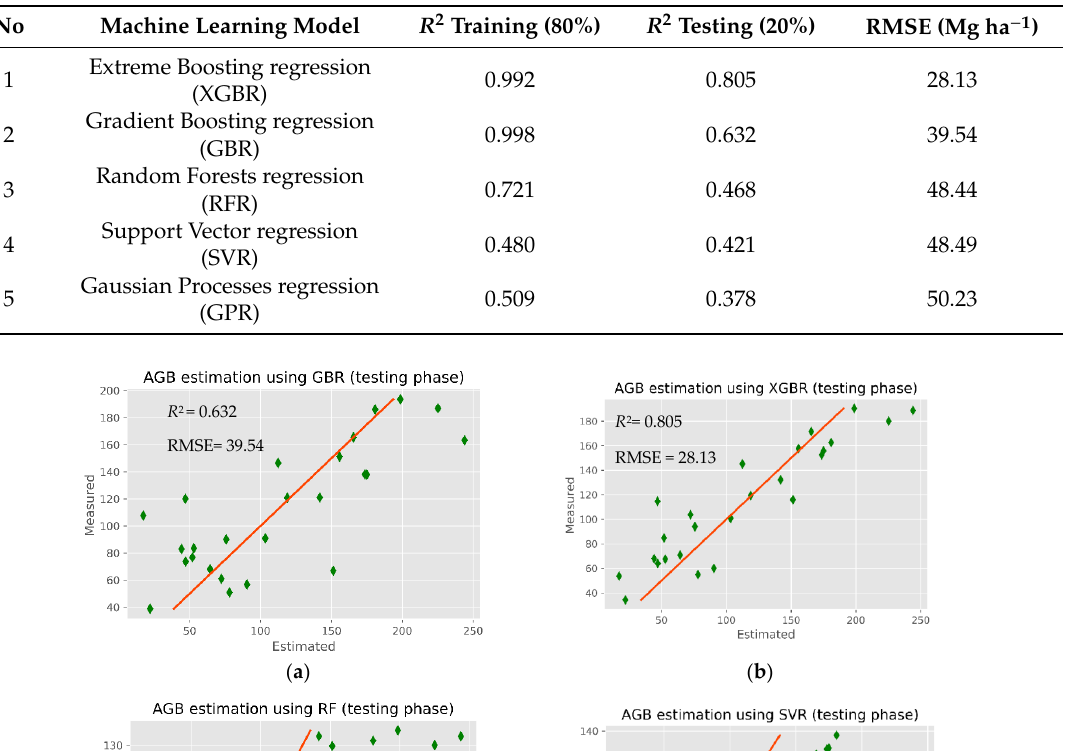
Table 6. Performance comparison of ML techniques on mangrove AGB estimation.